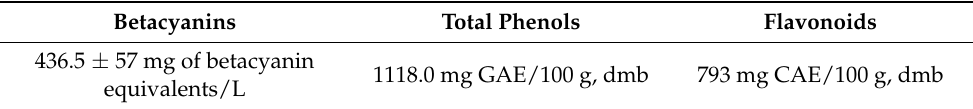
Table 2. Quantification of betacyanins, total phenolic compounds and flavonoids in OrP ( Opuntia robusta pulp); GAE/g = mg gallic acid equivalents/gram, dry matter basis (dmb); CAE/g = mg catechin equivalents/gram,